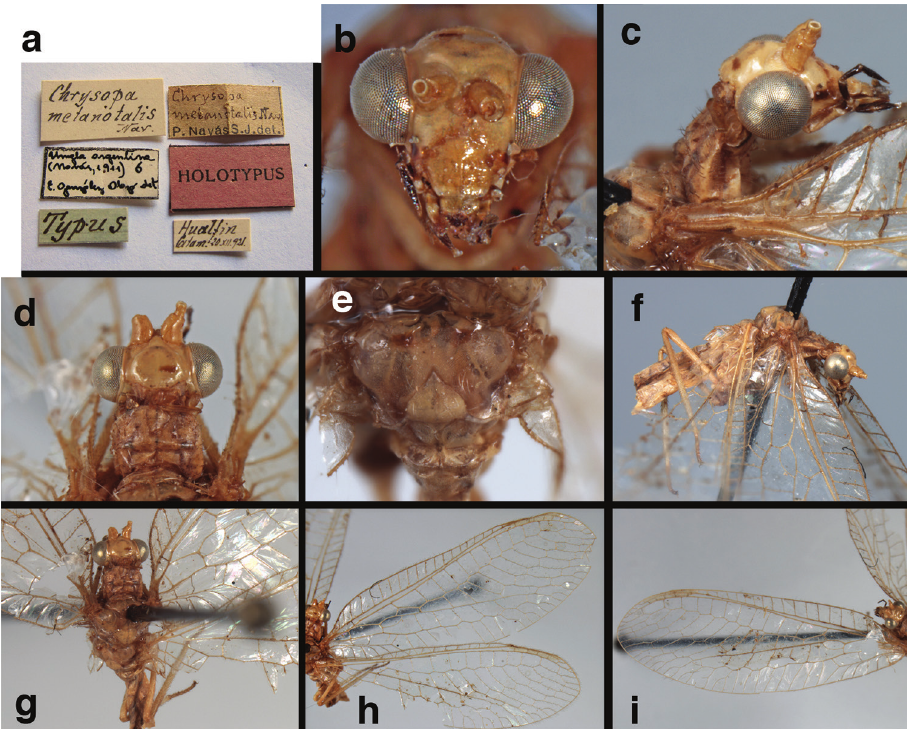
Figure 111. Chrysopa metanotalis Navás: External features, ( a ) labels ( b ) head, frontal ( c ) head, pro- thorax, lateral ( d ) head, prothorax, dorsal ( e ) metathorax, dorsal ( f ) body, lateral ( g ) body, dorsal ( h ) forewing ( i ) hindwing (Argentina, Catamarca, lectotype, male, MACN).